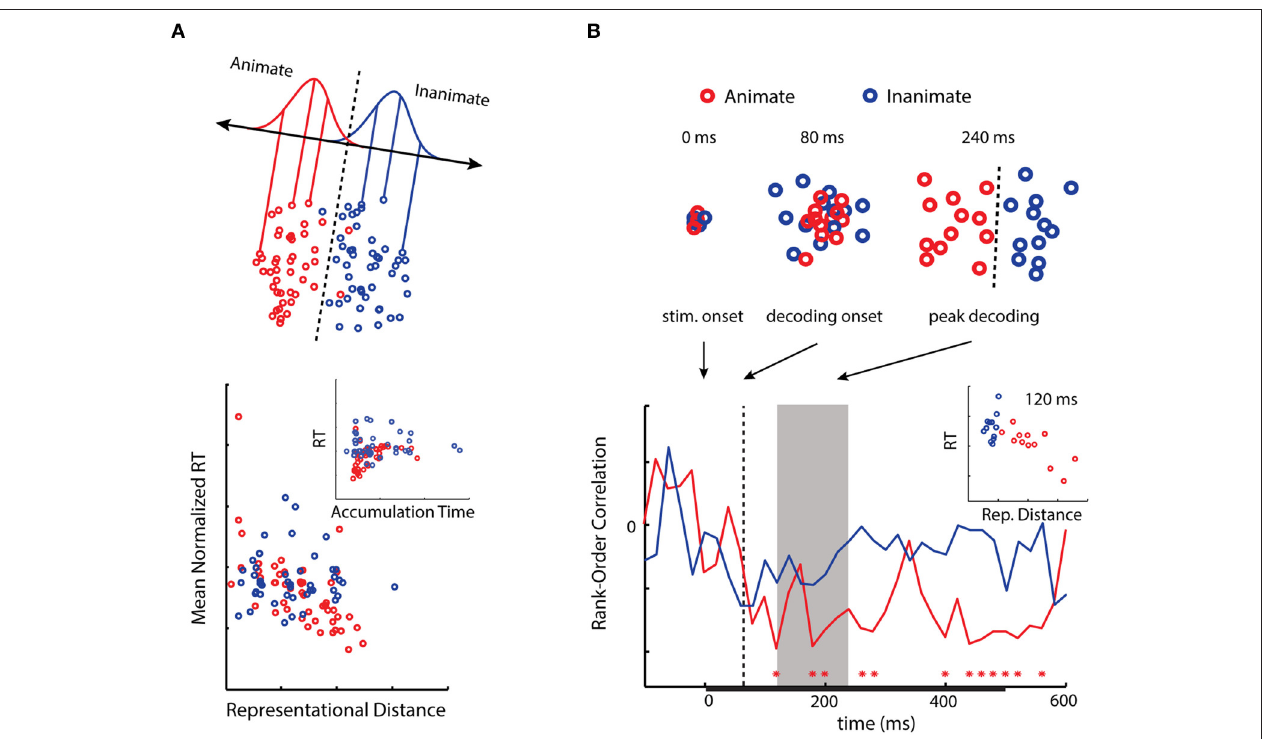
FIGURE 2 | (A) A 2D activation space for animacy in human IT. Distances from a decision boundary for animacy in human IT negatively correlate with RT as predicted from the neural distance-to-bound approach. When distance is transformed into a drift rate parameter, RT and evidence accumulation time positively correlate (modified from Carlson et al., 2014; © 2014 by the Massachusetts Institute of Technology). (B) Emergent activation spaces for animacy as reconstructed using MEG. Distances from decision boundaries at peak decoding (gray area) negatively correlate with RT (modified from Ritchie et al., 2015). Interestingly, for both results the correlations are primarily driven by the animate exemplar stimuli (for discussion, see Carlson et al.,